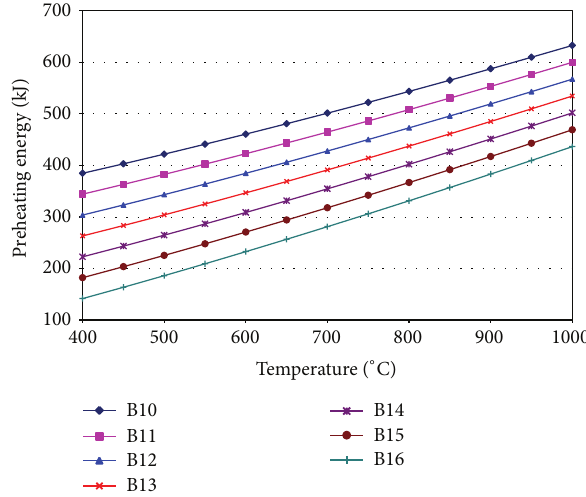
Figure 2: Preheating Energy in CR of